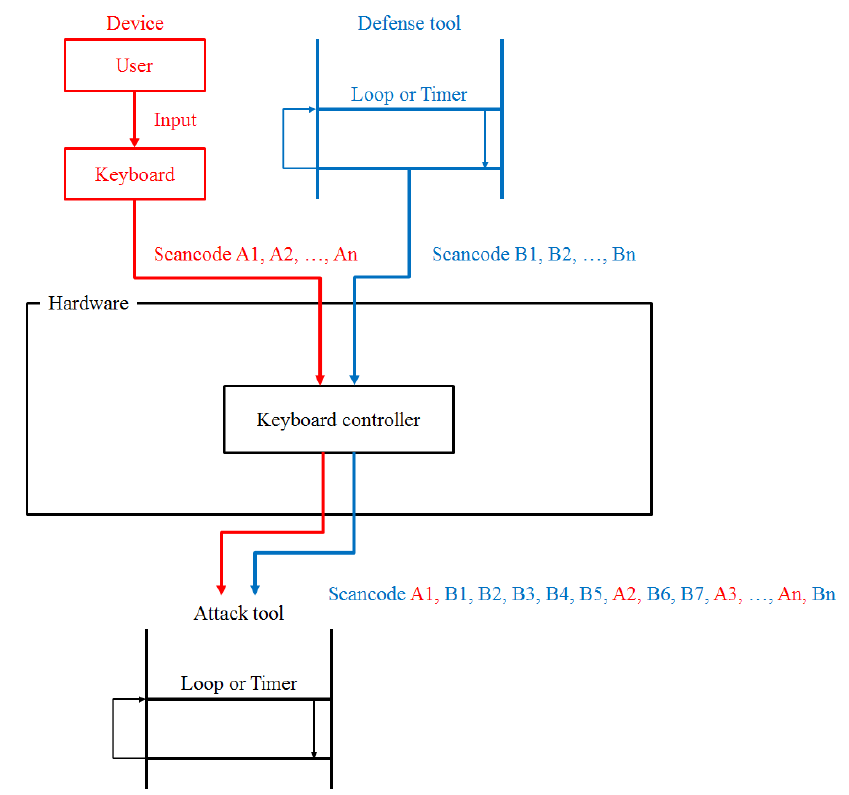
Figure 3. The proposed keyboard data attack system configuration. Table 2. Examples of collected scancodes.